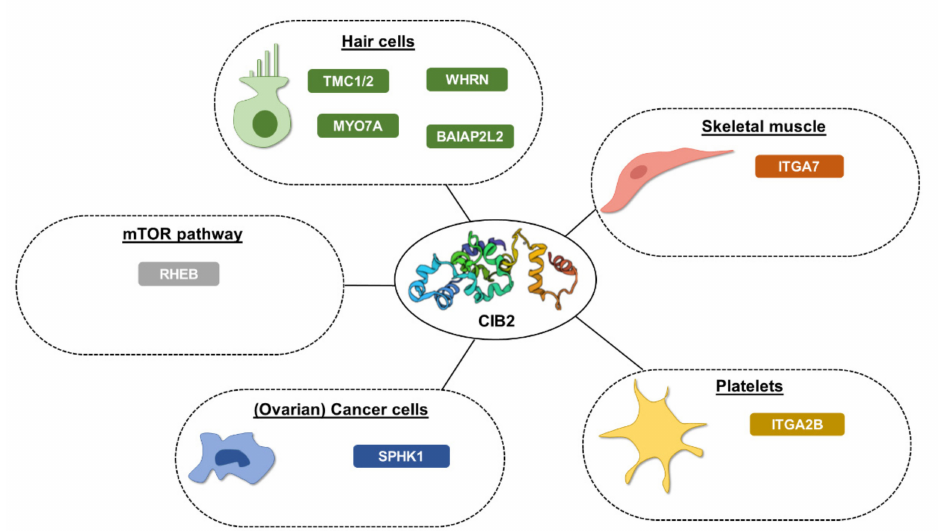
Figure 3. Experimentally determined CIB2 interactors as classified based on cellular type. Direct interactors supported by experimental evidence are listed. WHRN, whirlin; TMC1/2, transmembrane channel-like protein 1/2; MYO7A, unconventional myosin-VIIa; RHEB, GTP-binding protein Rheb; BAIAP2L2, BAI1-associated protein 2-like 2; ITGA7, integrin alpha-7; SPHK1, sphingosine kinase 1; ITGA2B, integrin